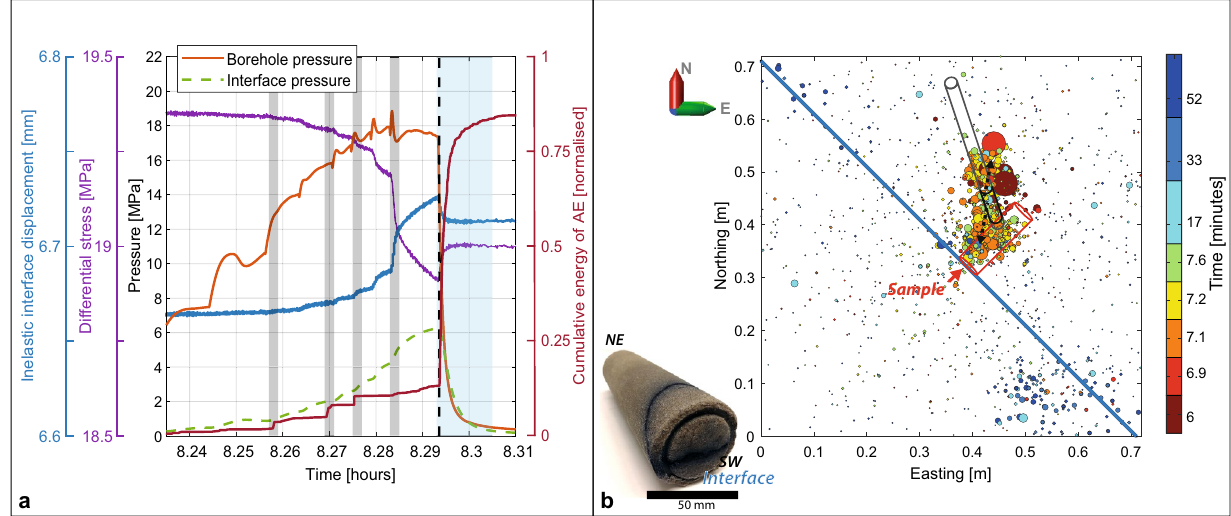
Figure 5. High-pressure fluid injection and fracture creation. ( a ) Increasing borehole pressure results in several high-energy AE-events (steps in cumulative AE energy, grey shaded areas depict the largest individual AE events) of primarily tensile-opening character (Fig. 4b). Shortly after reduction of the injection pressure (blue shaded area), a cascade of AE events occurred, with primarily mixed-mode and closing mechanisms. ( b ) AE event locations showing temporal evolution of the cloud from the injection point developing a bi-wing fracture both towards and away from the interface (see black dashed arrows). Size of events is related to AE-energy. Bottom left shows the rock sample drilled from the interface into the newly created fracture, showing blue ink where the fracture was